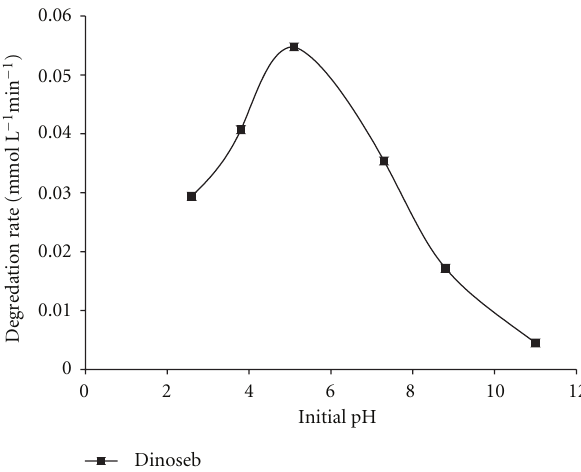
Figure 5: Influence of initial pH on the degradation rate of Dinoseb. Experimental conditions: reaction pH (2.6, 3.8, 5.1, 7.3, 8.8, and 11.0).